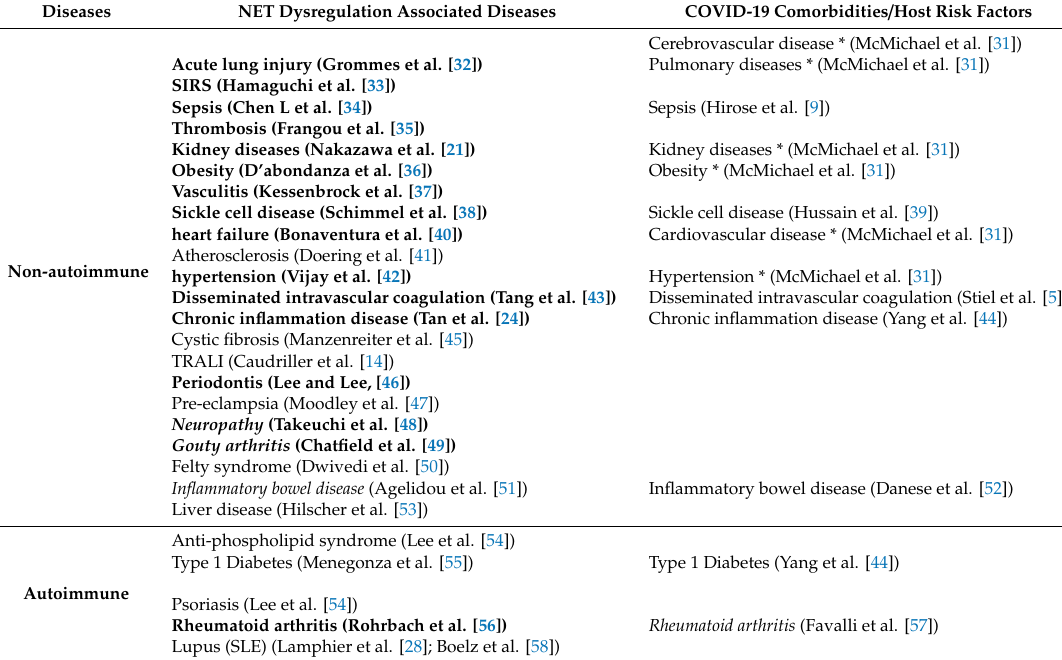
Table 1. Legend: comparison of neutrophil extracellular trap (NET) dysregulation associated diseases and coronavirus disease-2019 (COVID-19) comorbidities / host risk